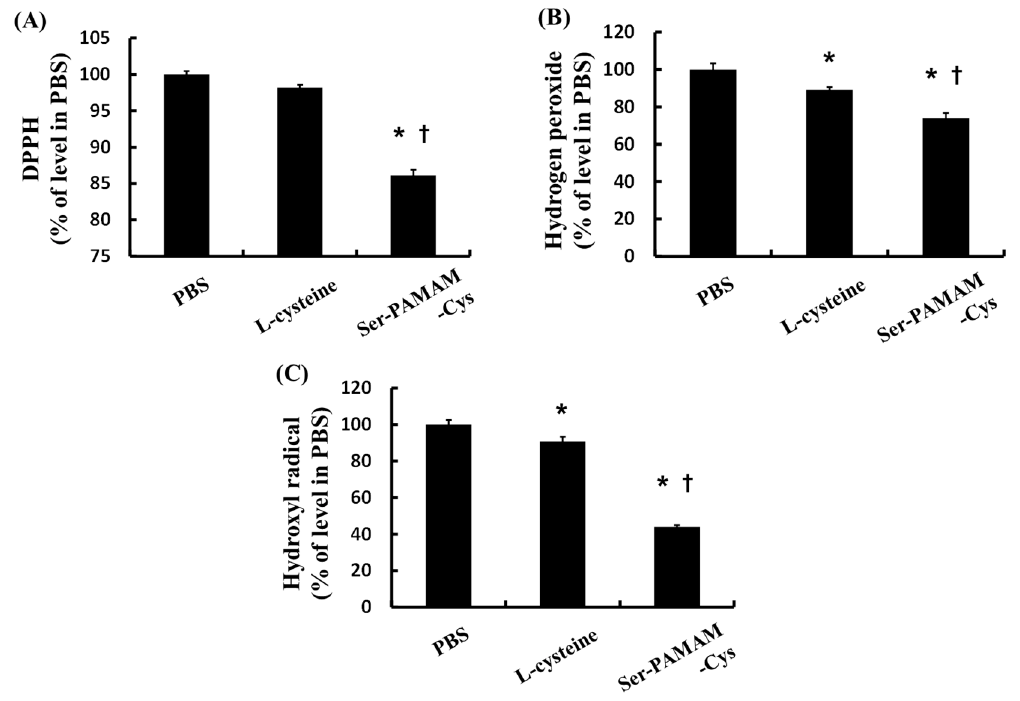
Figure 1. Relative abilities of L -cysteine and Ser-PAMAM-Cys to scavenge ( A ) DPPH, ( B ) hydrogen peroxide, and ( C ) hydroxyl radical. Results are expressed as means ± SE for five experiments. * p < 0.05: significantly different from the PBS group. † p < 0.05: significantly different from the L -cysteine group.